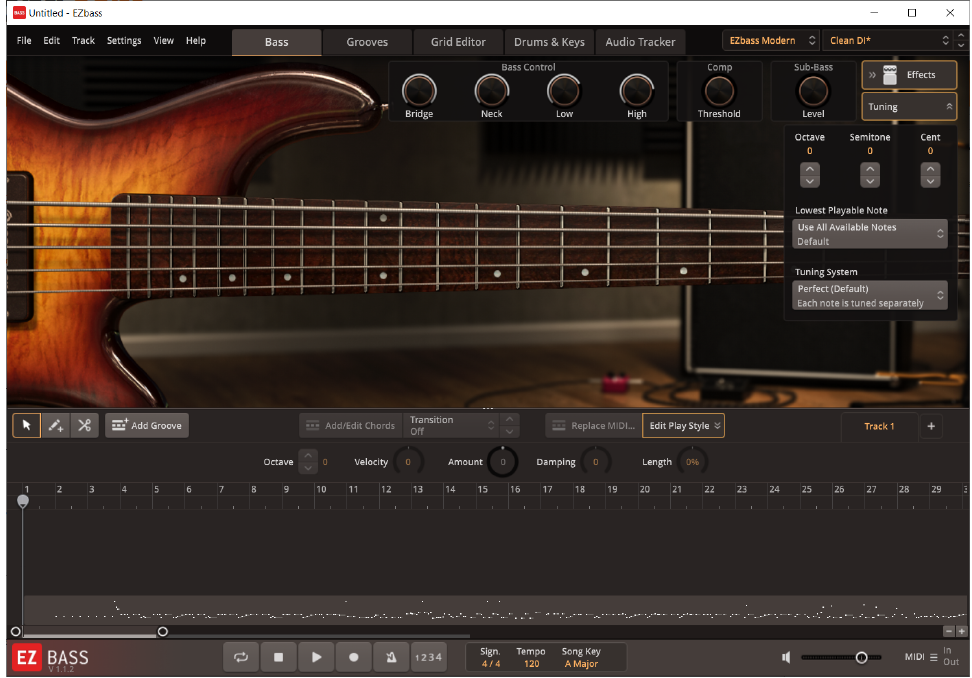
Figure 3. Toontrack EZ Bass. Courtesy of Toontrack Music